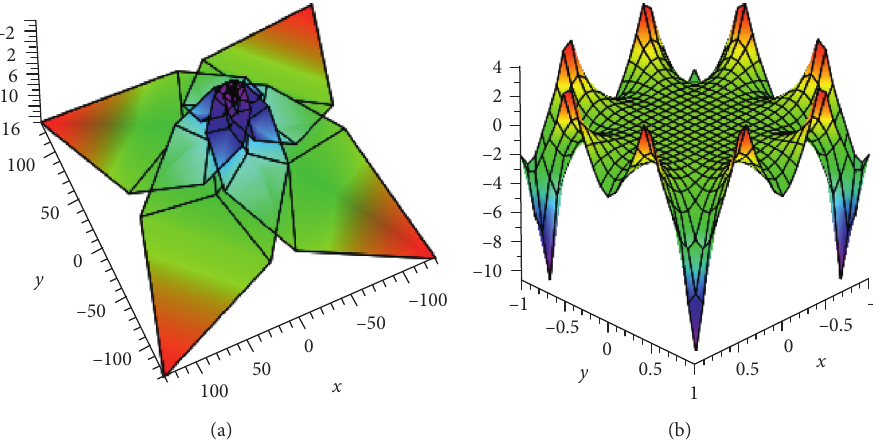
Figure 2: (a) Enneper seventh-order surface in the interval x ∈ [− 1 . 2 , 1 . 2 ] , y ∈ [− 1 . 2 , 1 . 2 ] ; (b) soliton deformation of inverted Enneper seventh-order surface at the point of origin for parameters a � b � c �